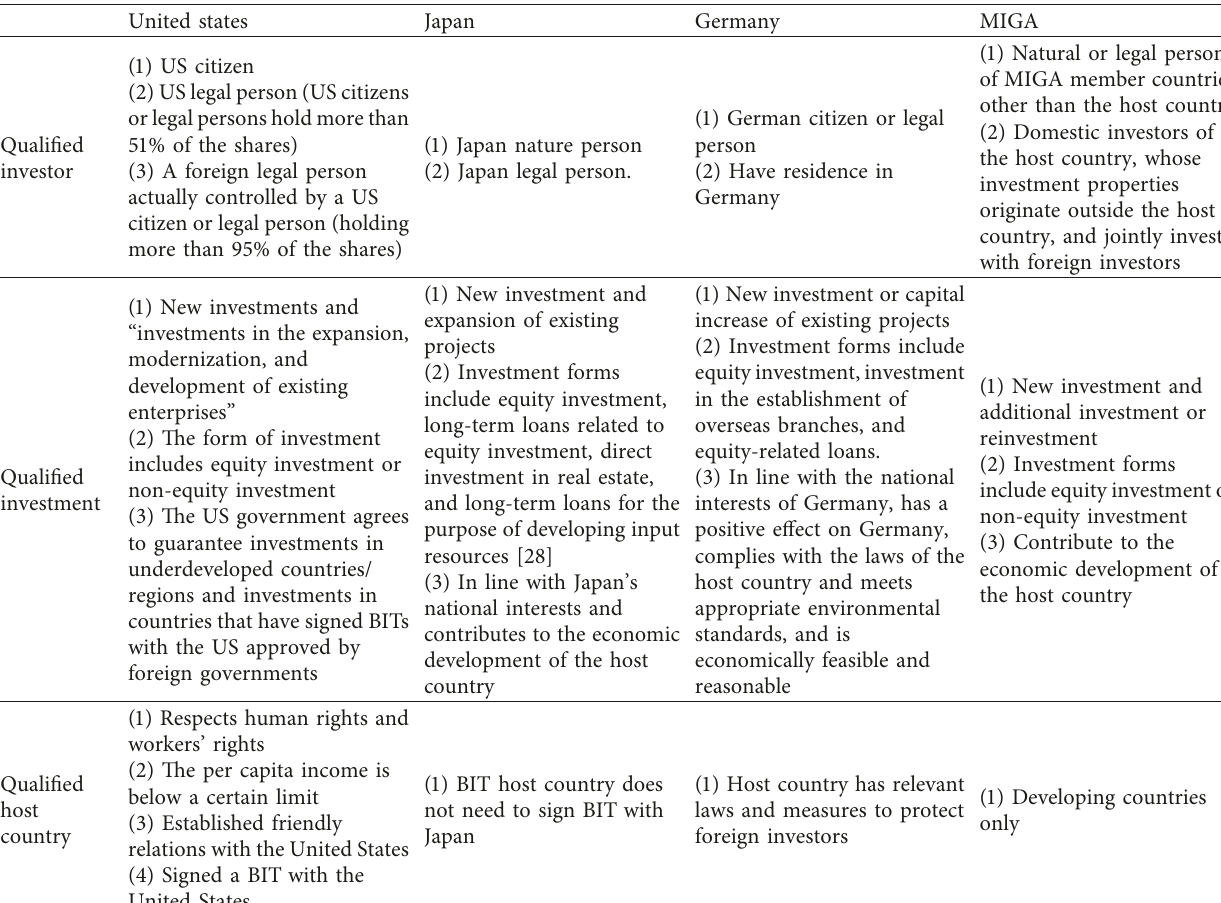
Table 2: Comparison of underwriting conditions of overseas investment insurance in various